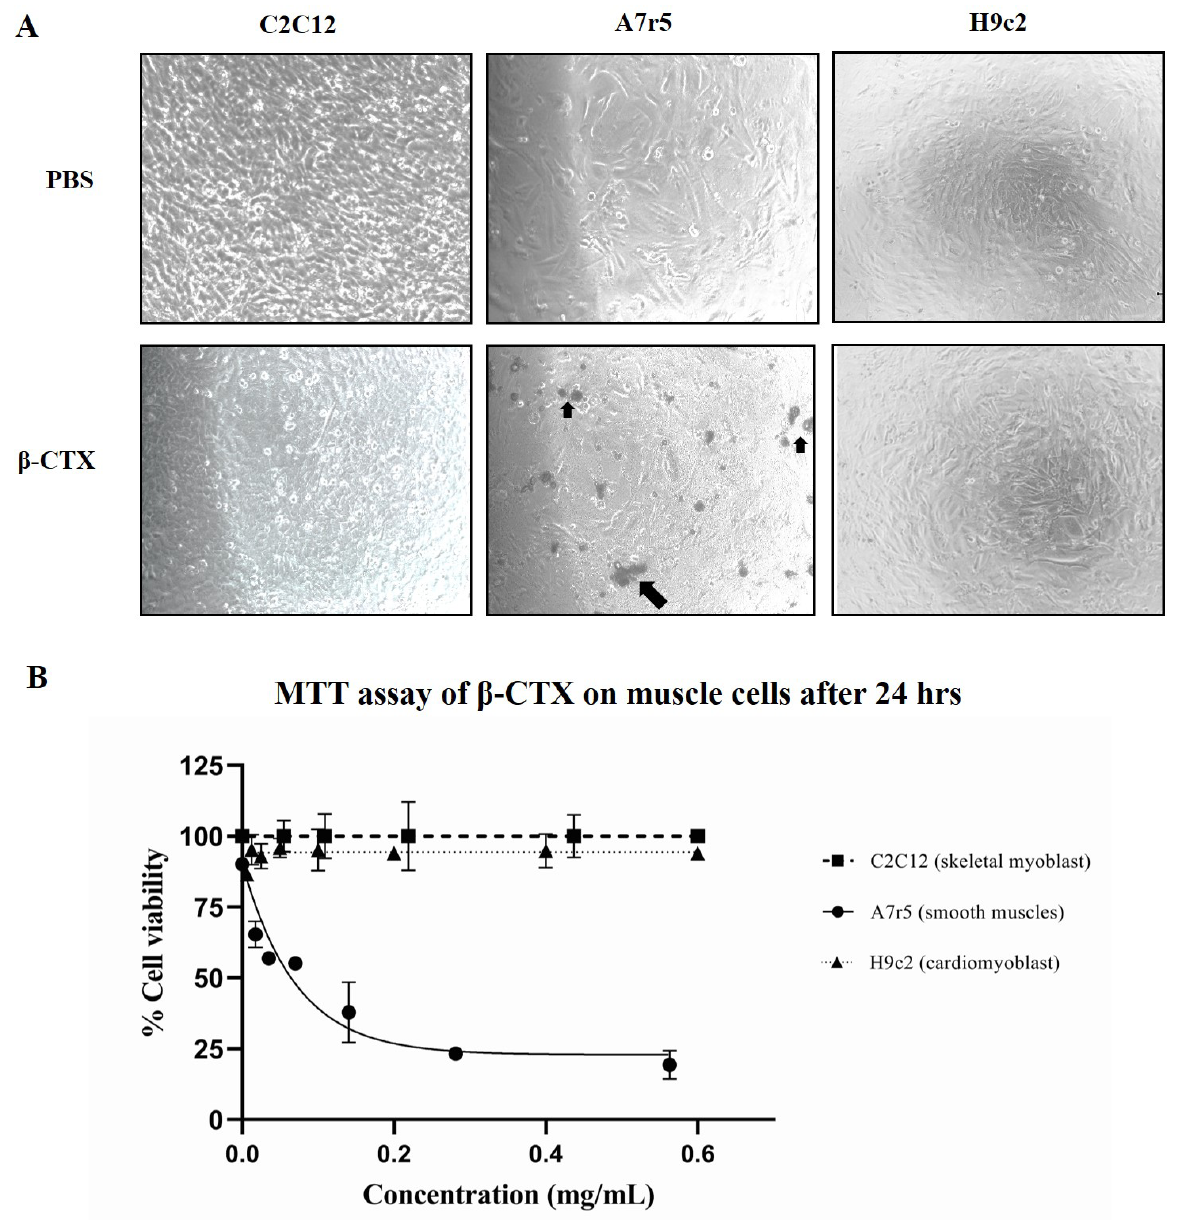
Figure 2. (A) Representative microscopic pictures of C2C12, A7r5 and H9c2 muscle cell lines treated with either PBS (top) or β-CTX (bottom). Concentration of β-CTX on C2C12 and H9c2 was 0.8 mg/mL, and on A7r5 was at 0.2 mg/mL, respectively. Morphological changes as well as dead cells (arrows) were observed in A7r5 cell-treated with β-CTX. (B) Percentage of cell viability as function of toxin concentration (n = 3; three replicates for each n). Data are presented as mean ±